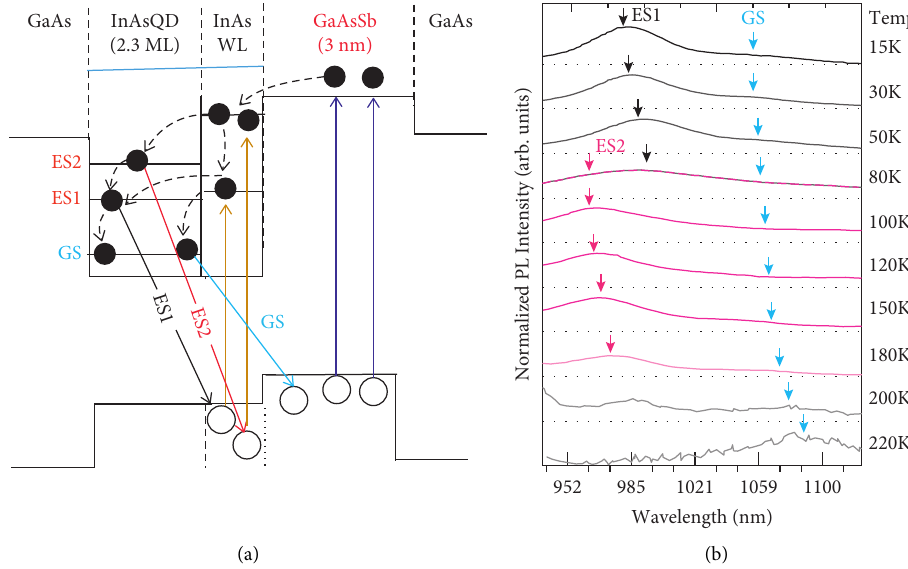
Figure 1: (a) Carrier excitation, transportation, and recombination paths and (b) Temperature-dependent PL experimental